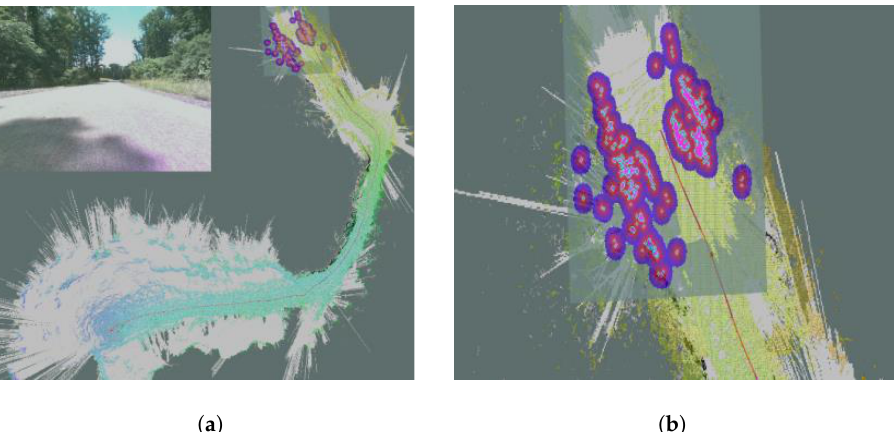
Figure 2. This is the global and local maps constructed by an autonomous robot when exploring an unknown terrain. The gray area represents the unknown area. ( a ) Robot autonomous navigation and mapping; ( b ) local map with observed